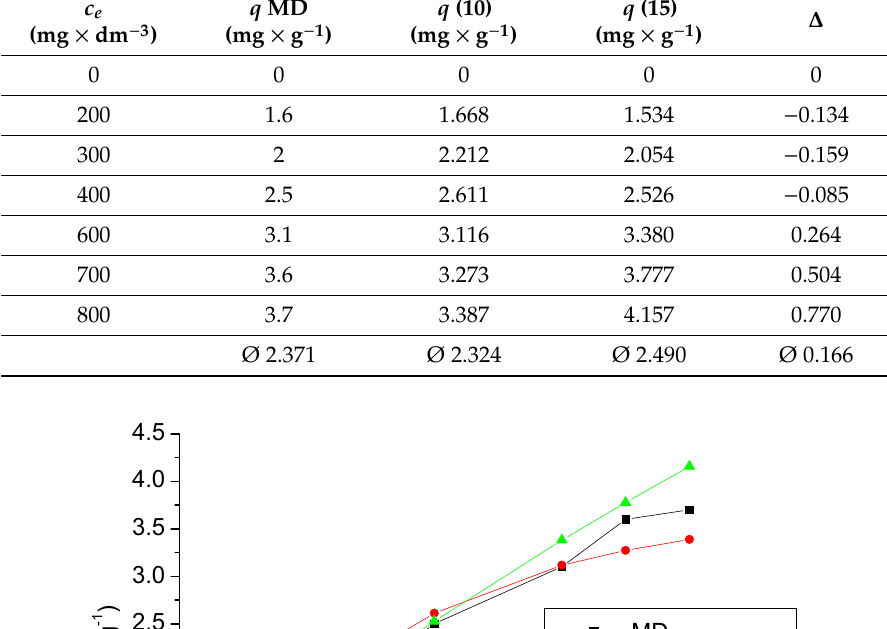
Table 3. Comparison of models with measured data (MD) and their mutual di ff erences.